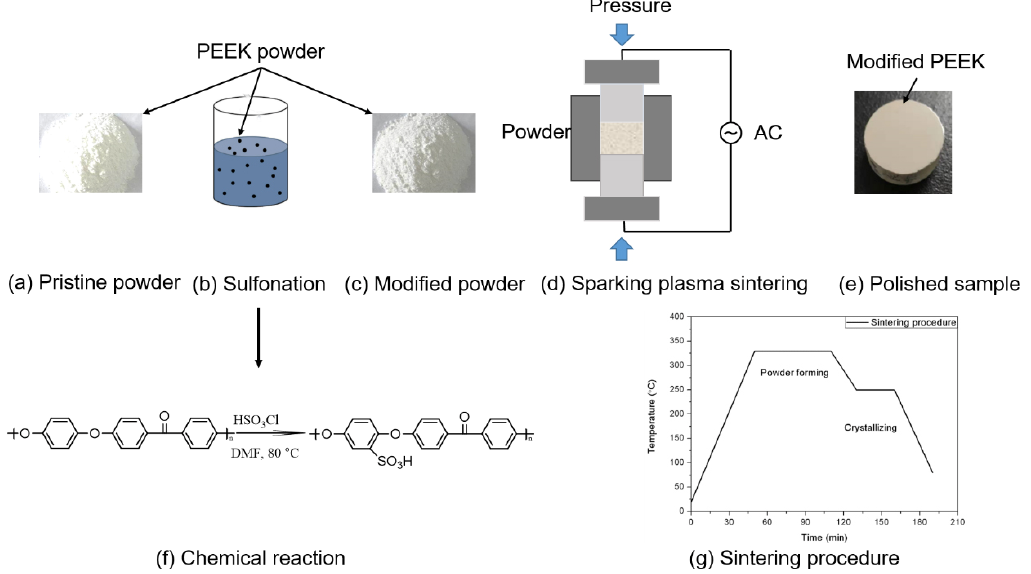
Fig. 1 Preparation of the sulfonated PEEK samples. (a–c, f) Sulfonation procedure of the PEEK powders and (d, e, g) sintering procedure for the SPEEK